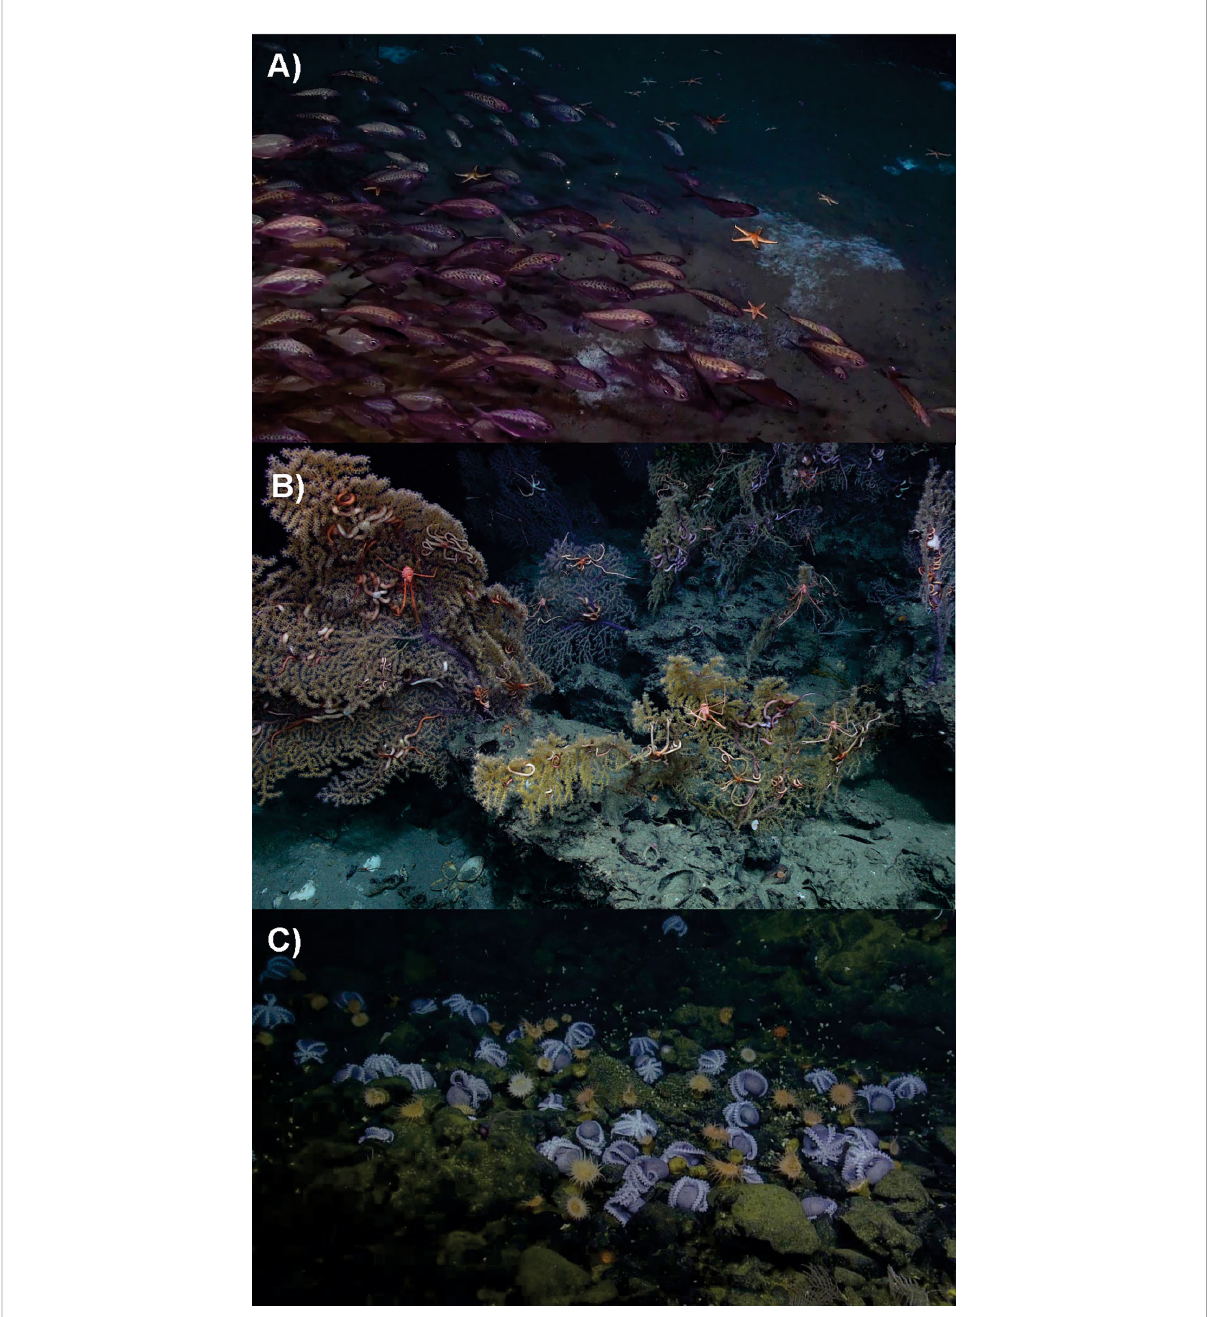
FIGURE 5 Connectivity between chemosynthetic ecosystems and background deep sea ecosystems. (A) A methane seep transition zone offshore North Carolina, USA. White bacterial mats indicate areas of active seepage, while the American butter fi sh ( Peprilus triacanthus ) and seastars are background deep-sea species visiting the seeps to take advantage of the chemosynthetic productivity. Image courtesy of Ivan Hürzeler, DEEP SEARCH project, and copyright Woods Hole Oceanographic Institution. (B) Seep transition zone with Paramuricea coral fans (like those impacted by the Deepwater Horizon oil spill) using substrate provided by seep-related carbonate rocks with embedded chemosynthetic clam shells. Image courtesy of Erik Cordes, ECOGIG consortium, and the Ocean Exploration Trust. (C) Extensive aggregations of brooding female octopuses ( Muusoctopus robustus ), “ octopus garden ” , associated with vents from Monterey Bay National Marine Sanctuary. Image courtesy of OCEAN EXPLORATION